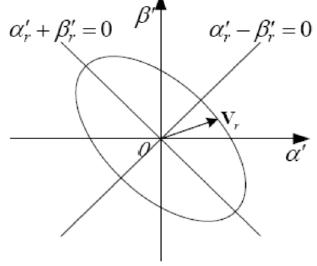
Figure 4. Trajectory of V r .